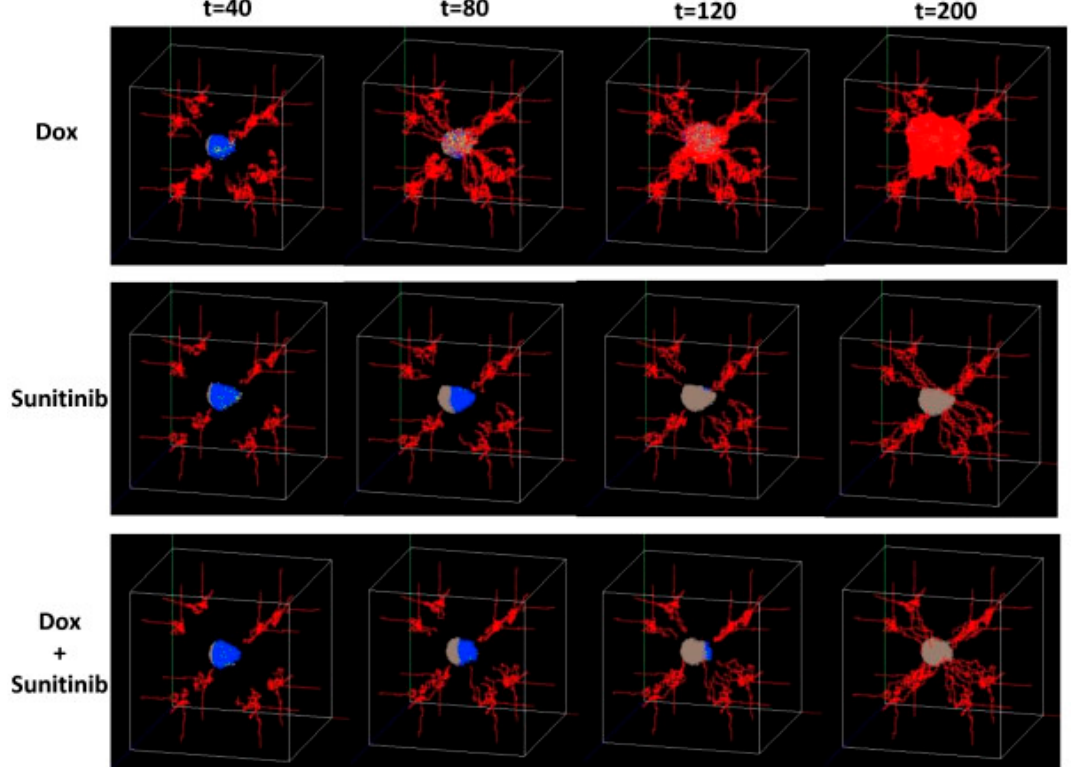
Figure 3. Representative 3D snapshots of the tumor response over time (t = 40, 80, 120, 200 h) and considering three drug-treatment scenarios: doxorubicin alone (Dox), sunitinib alone, and treatment with combined drugs (Dox + sunitinib). Reprinted from [111] under a CC BY 2.0 License. Copyright